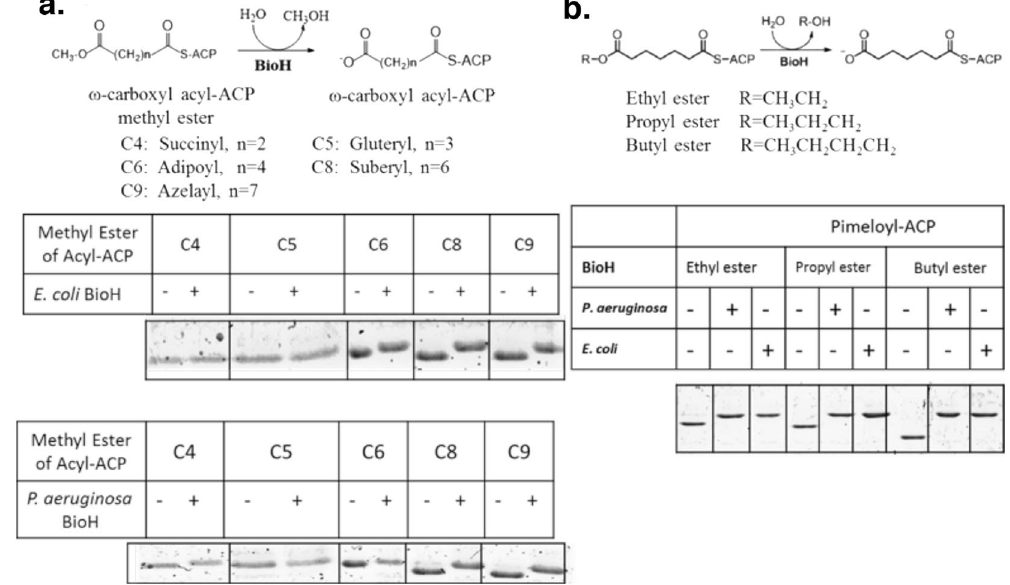
Figure 4. BioH-catalyzed hydrolysis of the ester bonds of various ω -carboxyl acyl-ACP esters. ( a) The reactions contained 50 mM Tris-HCl (pH 7.0), 5% glycerol, 5 μ g/ml BioH and 2 mM pimeloyl-ACP esters and were incubated at 37 °C for 30 min. BioH cleavage of the methyl ester moieties of acyl-ACP methyl esters having acyl chain lengths of 4 to 9 carbon atoms. ( b) BioH cleavage of the ethyl-, butyl- and propyl- esters of pimeloyl-ACP.